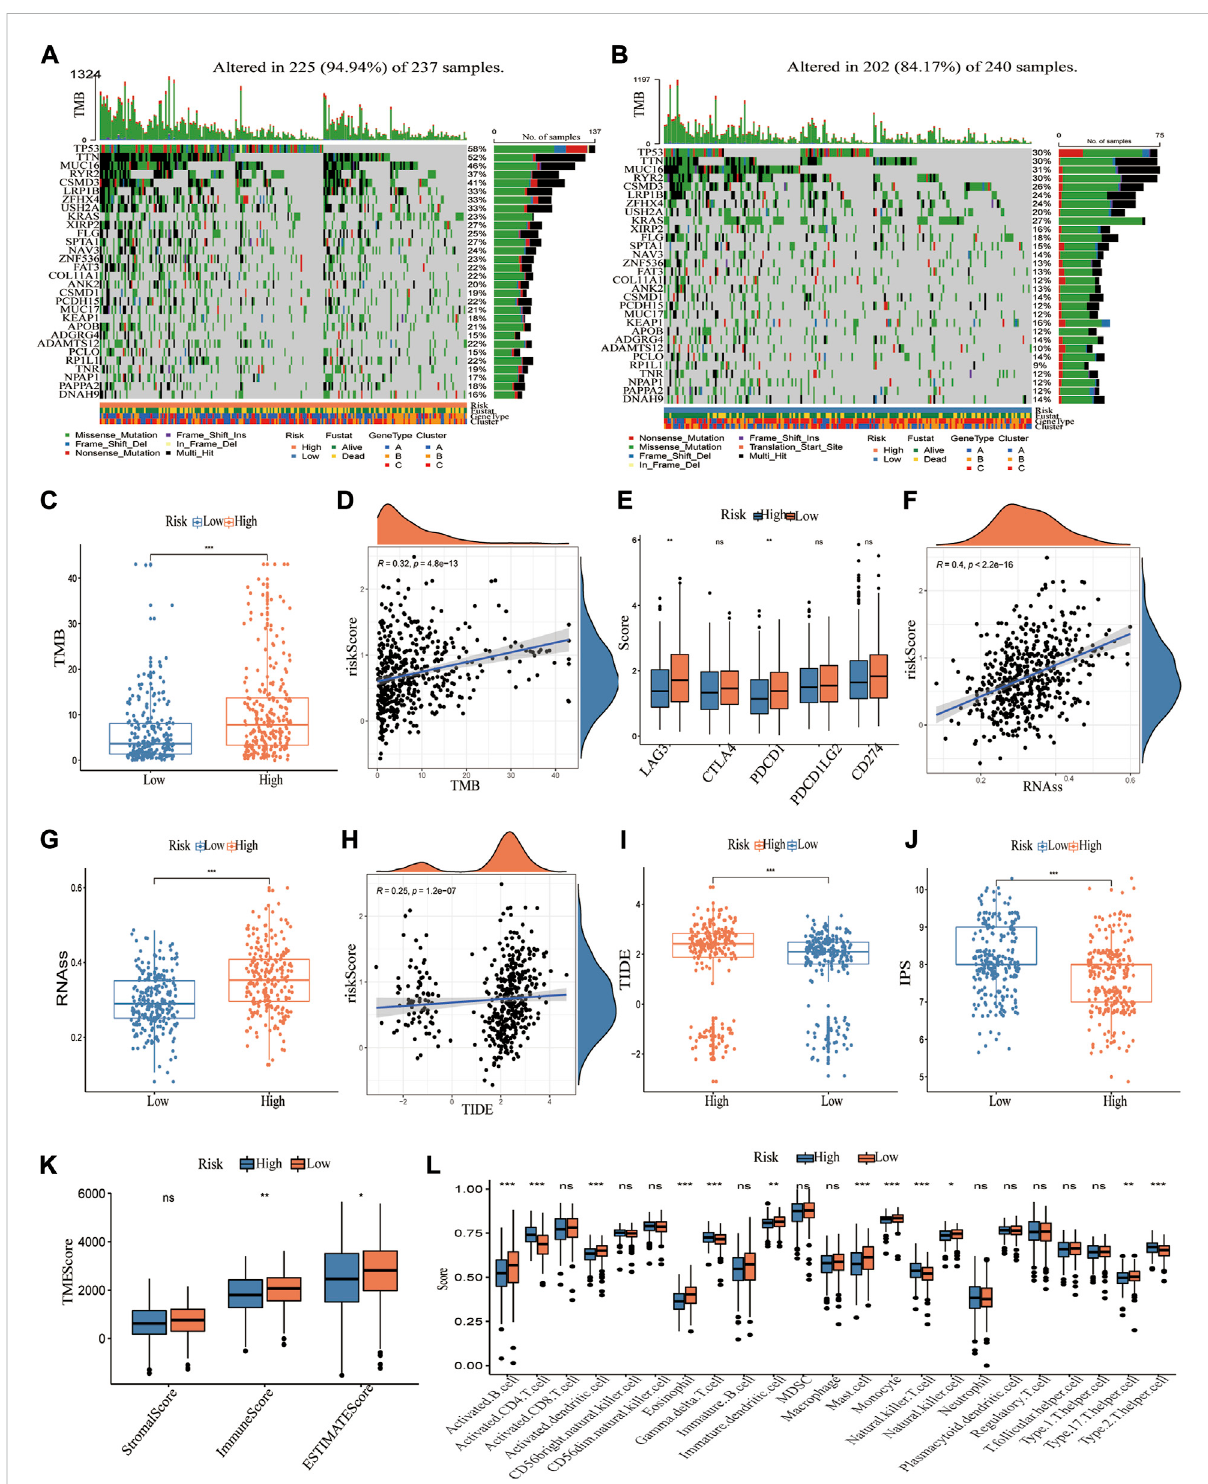
FIGURE 7 CharacteristicsofCRG_scoreinTCGAcohortandpredictingimmunotherapyresponse. (A,B) Thewaterfallplotdepictstheheterogeneityinthe somaticmutationlandscapeoftumorsacrossgroupswithlowandhighCRG_score. (C,D) Signi fi cantdifferencesofTMBinhighandlowCRG_score groups and correlation with therisk score. (E) Differential expression ofimmunecheckpoint-related genes in high and low CRG_scoregroups. (F,G) Signi fi cant differences of RNAss (cancer stemness cells index) in high and low CRG_score groups and correlation with the risk score. (H,I) Signi fi cant differences of TIED score in high and low CRG_score groups and correlation with the risk score. (J) The boxplot demonstrated that IPS was signi fi cantly higher in the high CRG_score group than in the low CRG_score group. (K) The TME score in the high and low CRG_score group. (i) 23 TME cells in fi ltration for the two risk groups. *, **, and ***, represent p < 0.05, p < 0.01, and p < 0.001,